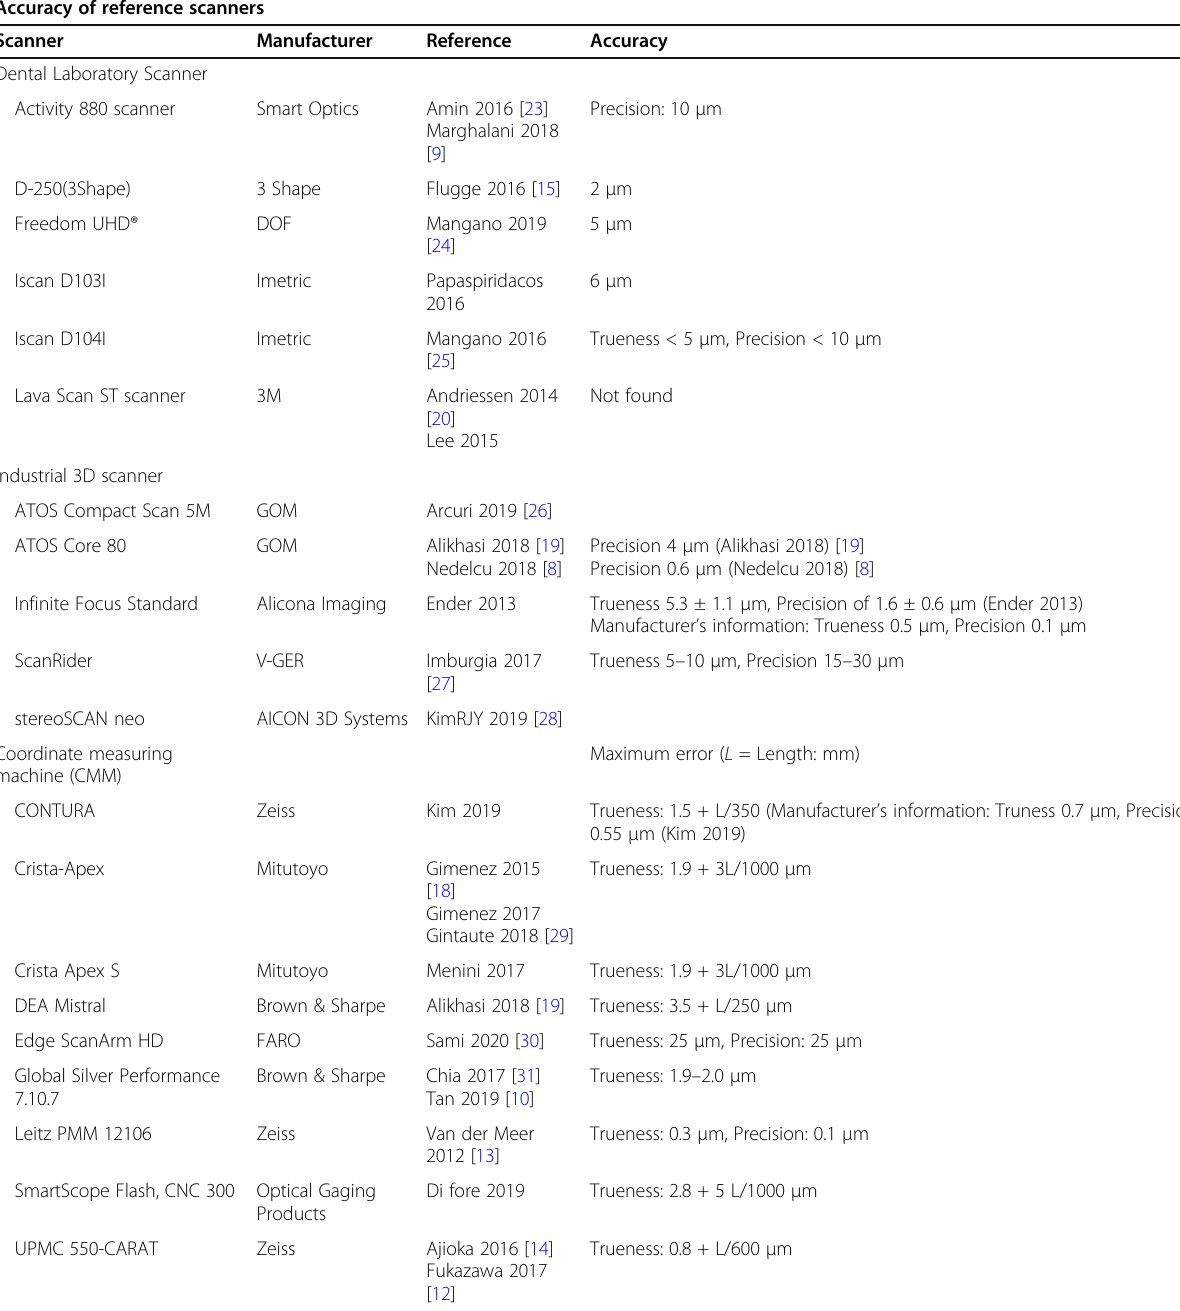
Table 1 Types of dental laboratory scanners, industrial 3D scanners, and CMMs used in the cited references and their accuracy Accuracy of reference